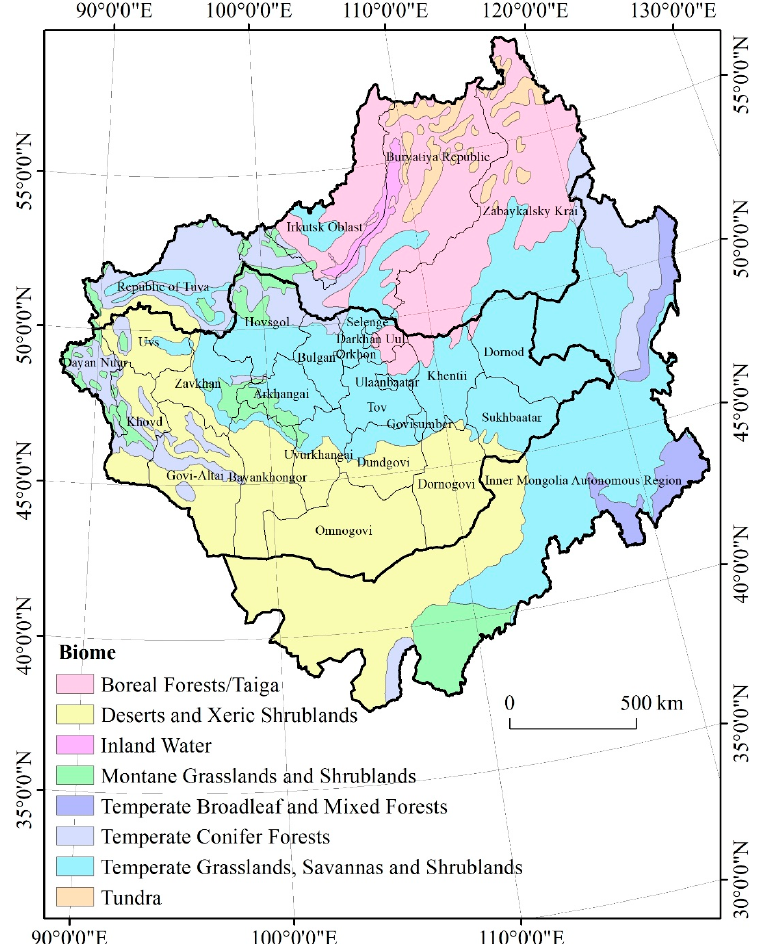
Figure 3. Biome distribution of the MP based on the World Wildlife Fund (WWF) terrestrial ecoregion map.